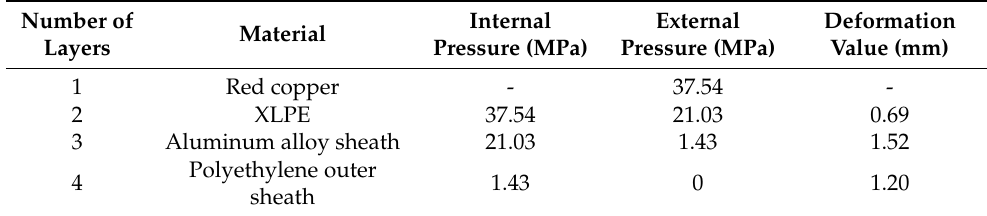
Table 4. Deformation of each layer of the cable, and calculated internal and external pressure values.